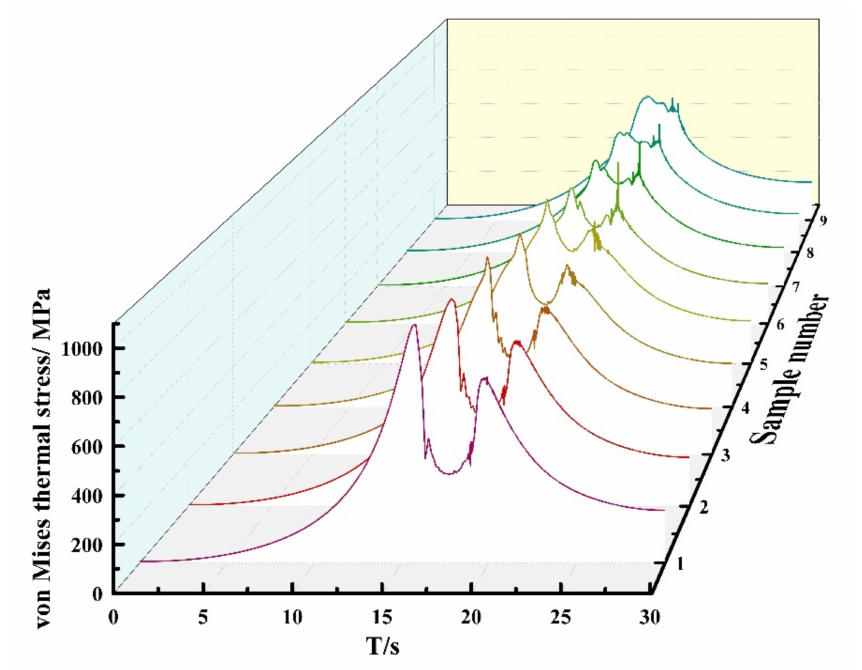
Figure 8. Von Mises thermal stress